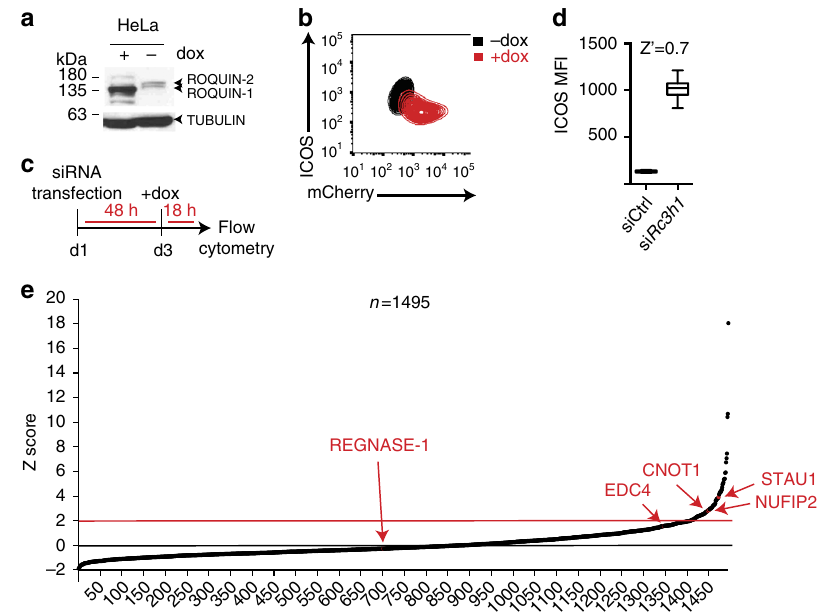
Fig. 1 A targeted siRNA screen to identify cofactors of Roquin-mediated post-transcriptional gene regulation. a Immunoblot analysis of Roquin-1, Roquin-2, and α -Tubulin expression or b fl ow cytometry of ICOS and mCherry expression in HeLa reporter cells containing cassettes for stable ICOS and doxycycline- inducible Roquin-1-P2A-mCherry overexpression. Cells were either treated with doxycycline (dox) for 18 h or left untreated. c Schematic representation of the screen work fl ow. d Distribution of ICOS mean fl uorescence intensity (MFI) in HeLa reporter cells after transfection with Roquin-1-targeting siRNA pools ( siRc3h1 ) or non-targeting control siRNAs (siCtrl) in a 96-well plate. The Z ′ factor was calculated from mean and SDs of positive ( siRc3h1 ) and negative (siCtrl) control data. e Normalized screen data of the customized siRNA library for Roquin-1 cofactors. ICOS MFI of each sample was normalized into a Z score based on plate mean and SD. Ranked Z scores are shown for each siRNA pool. Each data point with an average Z score > 2 was considered